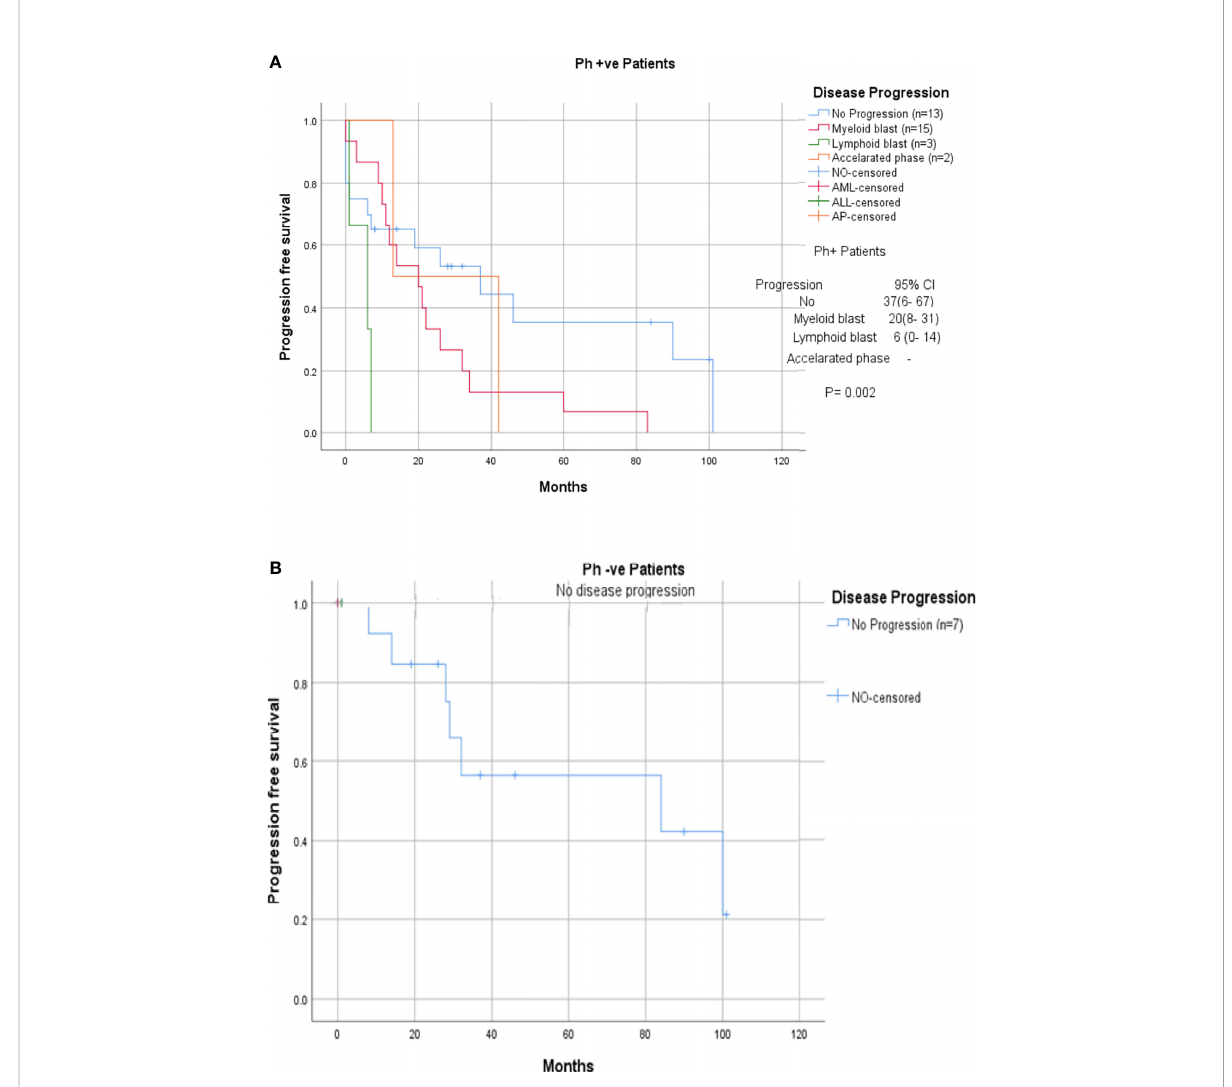
FIGURE 3 (A, B) CML patients with different groups of ACAs (group 1, group 2, group 3, and group 4) and their respective of progression-free